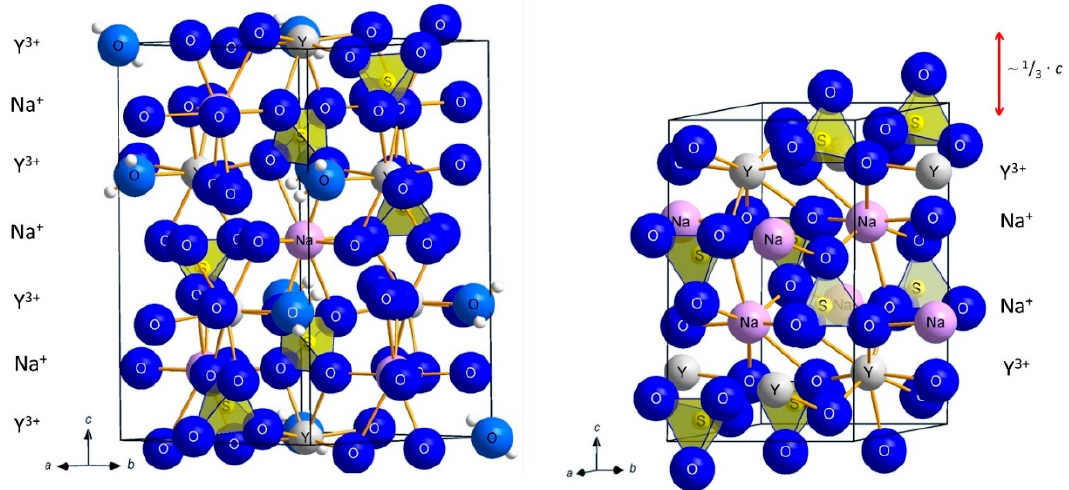
Figure 3. Extended unit cells of NaY[SO 4 ] 2 · H 2 O ( left ) and NaY[SO 4 ] 2 ( right ). While in NaY[SO 4 ] 2 · H 2 O monolayers of Na + and Y 3+ alternate along [001], in NaY[SO 4 ] 2 double layers of each Na + and Y 3+ do so.